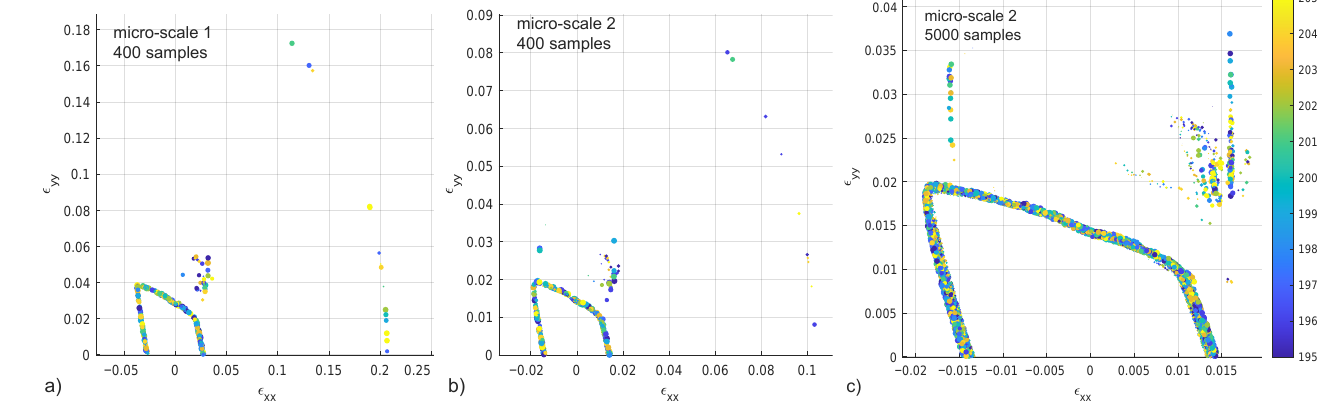
Figure 7. Failure points in the xx – yy strain space for the micro-scale 1, 400 samples ( a ), micro-scale 2, 400 samples ( b ), detail of micro-scale 2, 5000 samples ( c ). Colorbar represents the number of steps [195–205] and the diameter of the dots the tolerance threshold [0.001–0.0001]. Files available in the supplementary